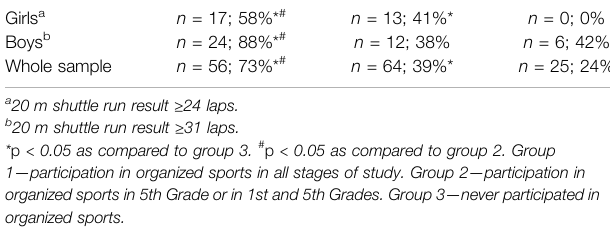
TABLE 4 | Percentage of 11.5-year-old children with healthy cardiorespiratory fi tness according to participation in organized sports.